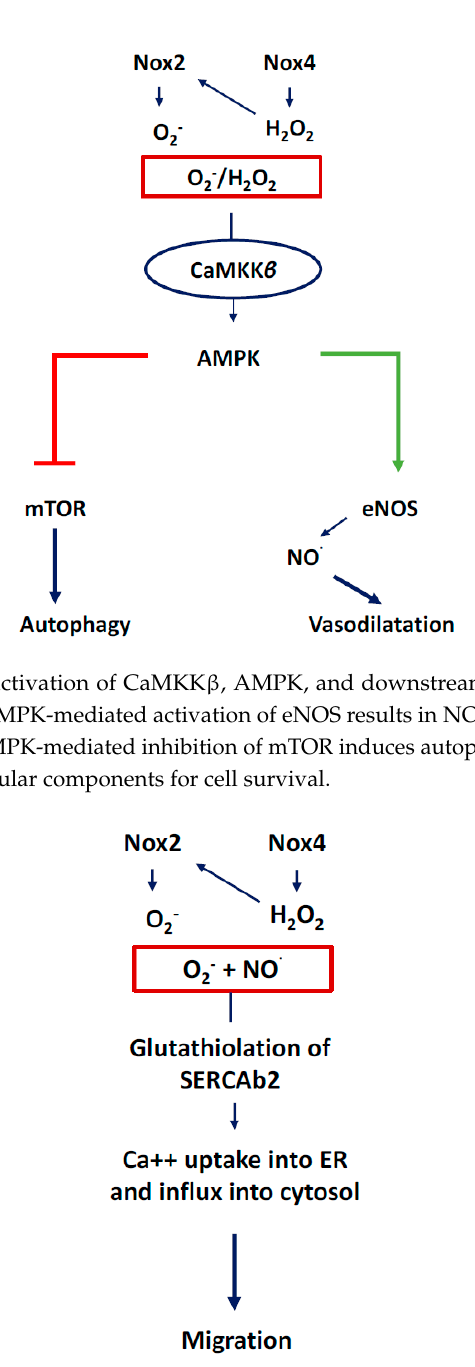
Figure 12. ROS-induced glutathiolation of SERCAb2 mediates endoplasmic reticulum (ER) Ca ++ uptake, which, in turn, results in endothelial cell migration, an important cellular function involved in angiogenesis. Both O 2 − and NO · are involved in the activation of signaling cascades that phosphorylate sarcoplasmic/endoplasmic reticulum calcium ATPase-b2 (SERCAb2) to increase the influx of Ca ++ into the cytosol and endoplasmic reticulum, stimulating endothelial cell migration.